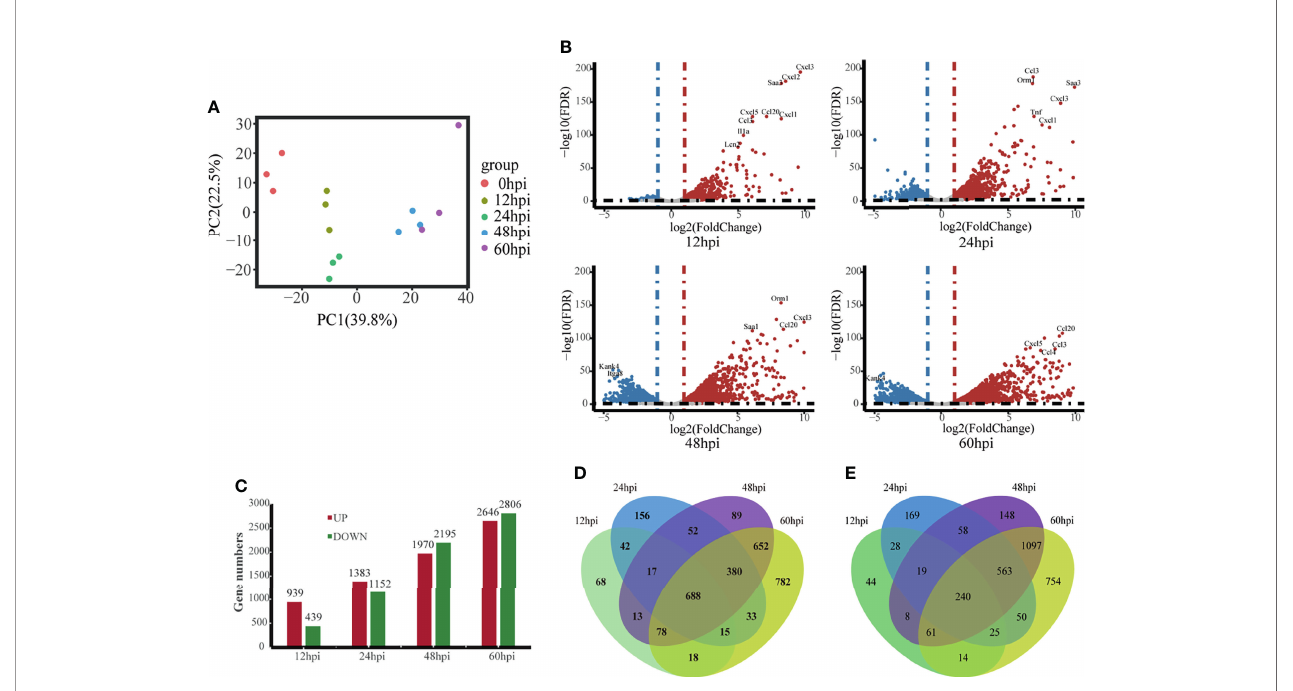
FIGURE 2 | Overview of time-course transcriptome analysis based on the value of FPKM of all groups. (A) PCA of the normalized RNA-Seq data of lung tissues in response to hvKp infection. The same color represents the same stages in replicates. (B) Volcano plot of RNA-Seq transcriptome data displaying the pattern of gene expression. Signi fi cantly differentially expressed genes (DEGs, FDR P ≤ 0.05) are highlighted in red (up-regulated) or blue (down-regulated). Curated genes with specialized biological functions are indicated with labels. (C) Number of DEGs at different time points. (D) Venn diagram comparing the up-regulated DEGs. (E) Venn diagram comparing the Down-regulated DEGs. All transcriptome experiments were performed in biological triplicate.